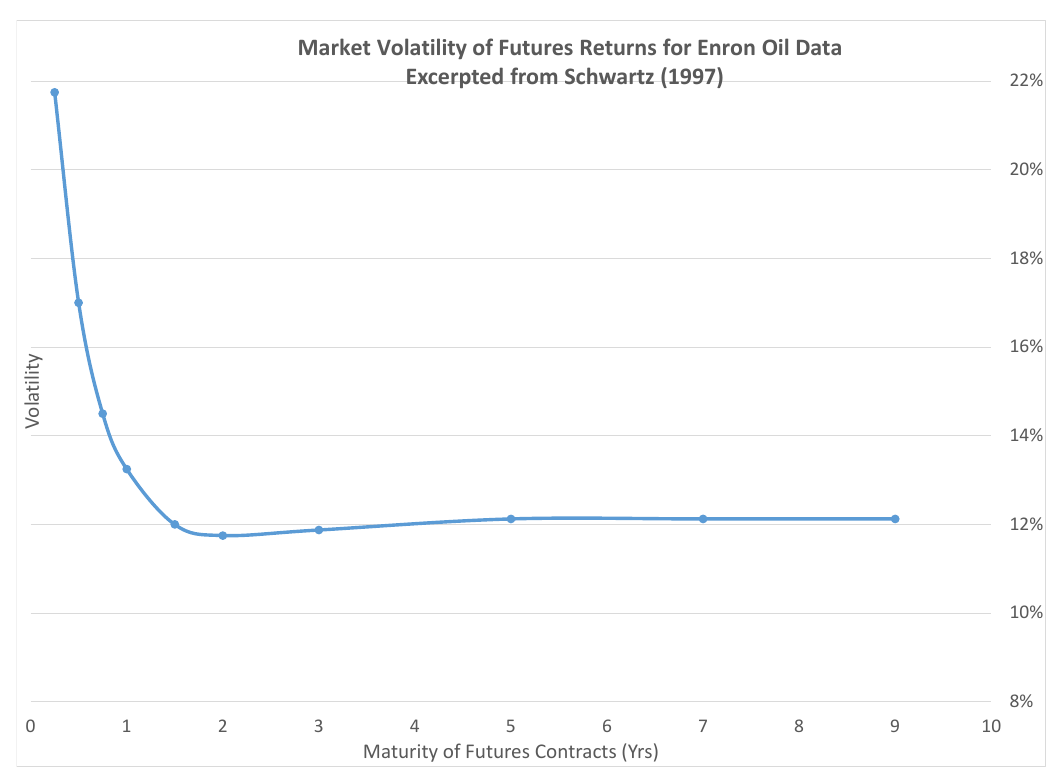
Figure 1. Market Volatility of Futures Returns for Enron Oil Data Enron Oil Data Excerpted from Schwartz